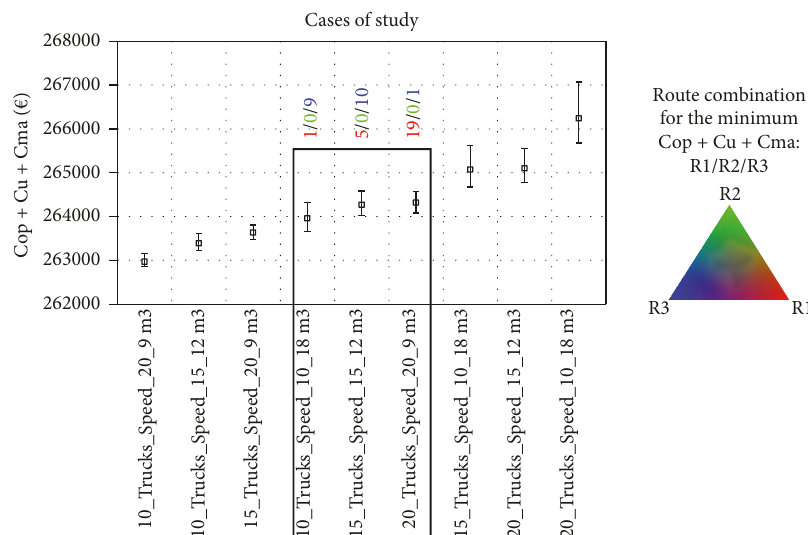
Figure 4: Total cost value for the cases of